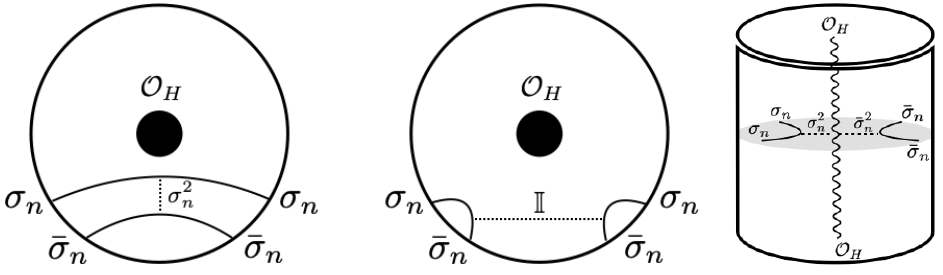
Figure 15 . There are several dominant channels for the 6-point correlation function describing the logarithmic negativity and odd entropy in a high-energy